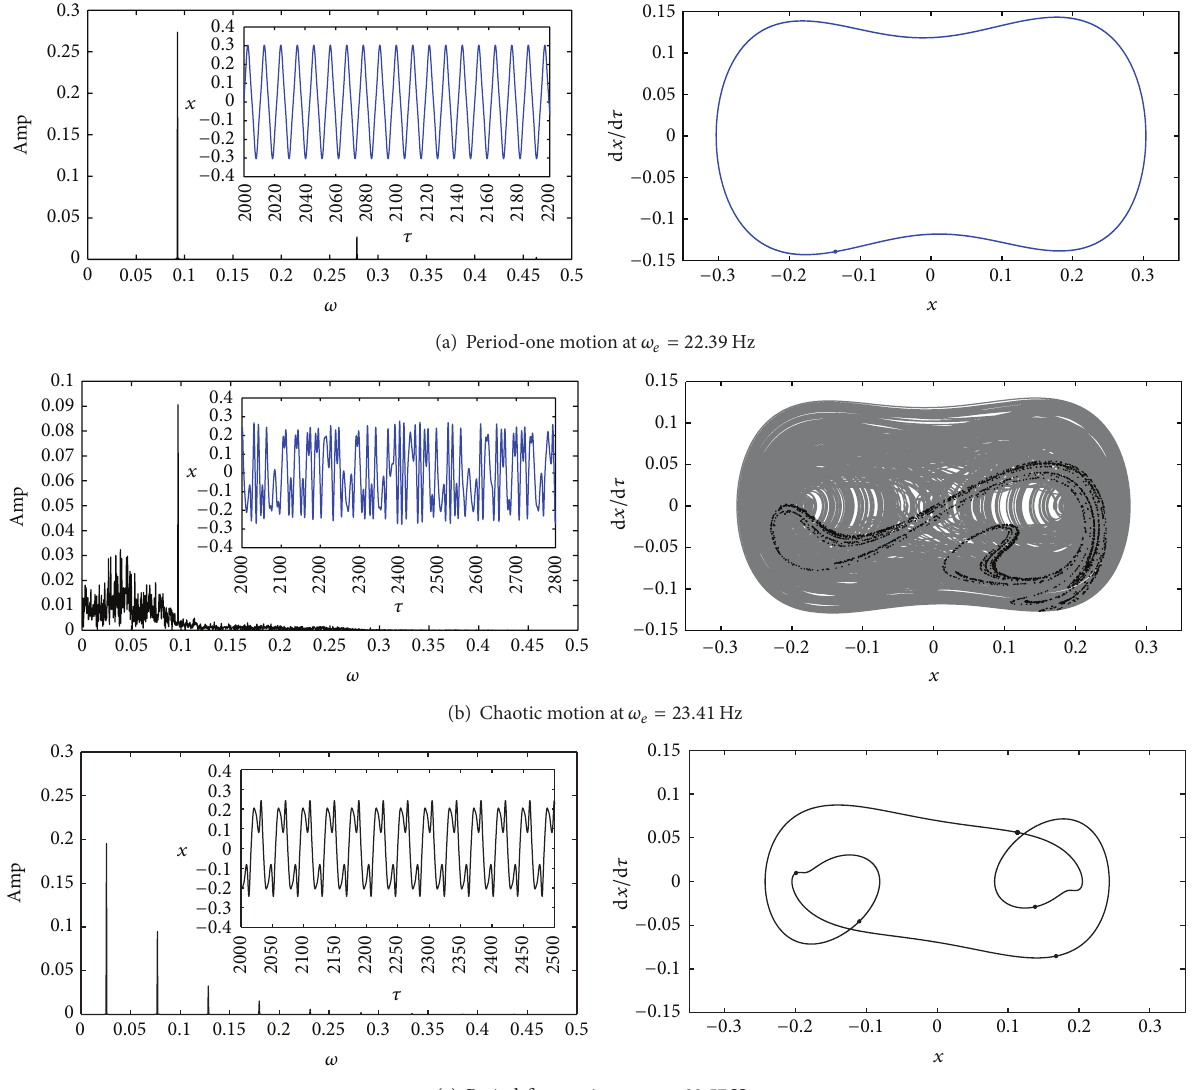
Figure 6: System response obtained numerically with different excitation frequency. Left: time series and frequency spectrum; right: phase trajectory and Poincar´e